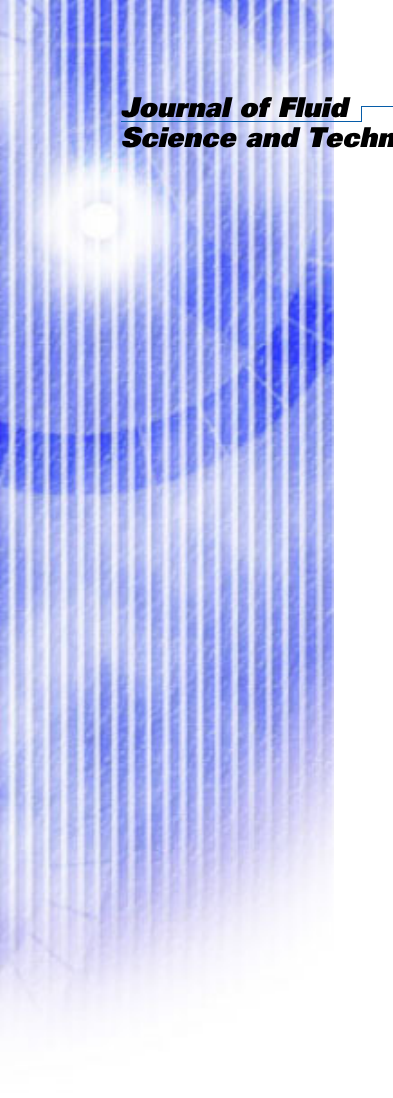
Fig. 2 Periodic capsule profiles for di ff erent ¯ u 1 and ¯ u 2 when ρ = 0 . 001, σ = 1 and ¯ b = 0 . 1; (a) initial profile at t = 0, (b) ¯ u ¯ u 2 = 0 at t = 1 .